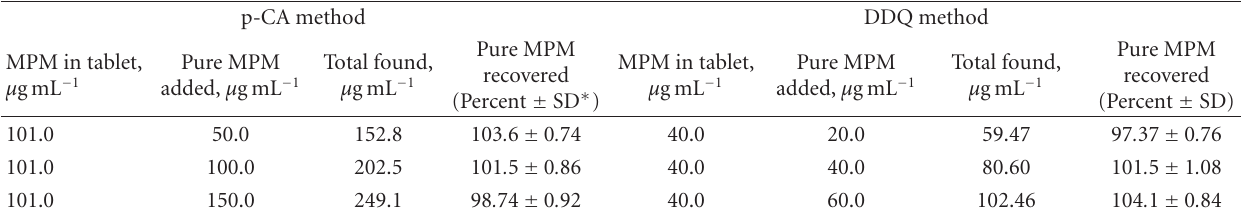
Table 5: Results of recovery study via standard-addition method with CellCept